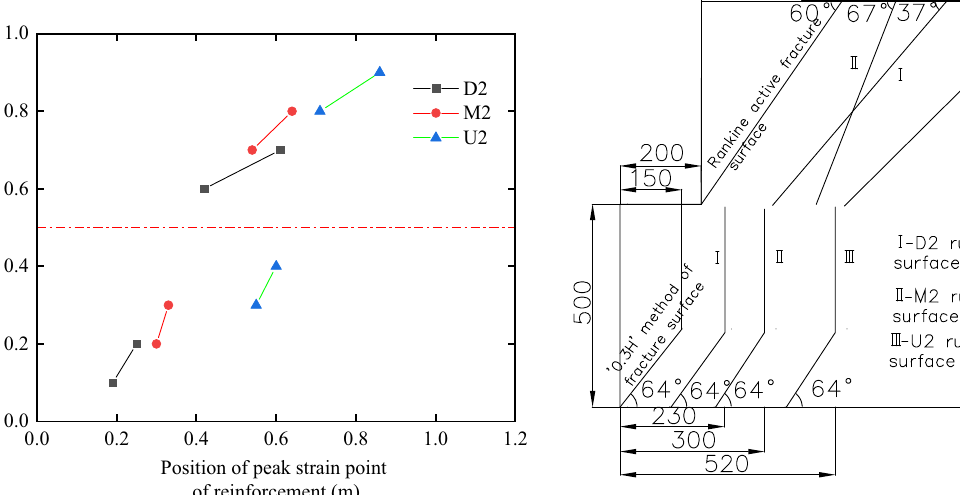
Figure 11: Potential rupture surface of a retaining wall under three working conditions ( unit: mm )